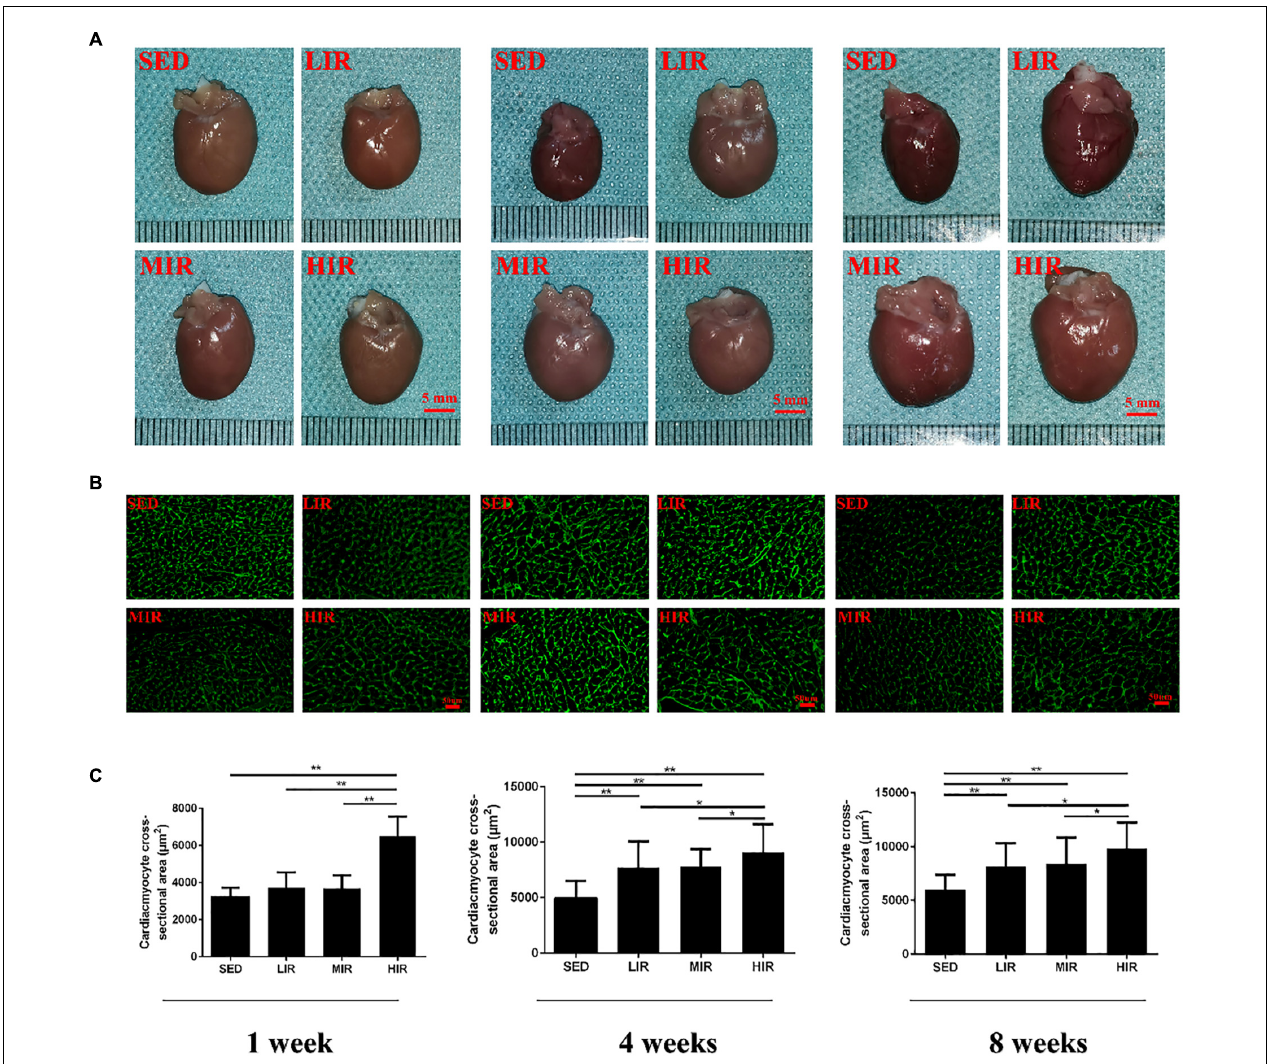
FIGURE 1 | SD rats were subjected to different treadmill running intensities for 1, 4, and 8 weeks. (A–C) Hypertrophic changes of the hearts were observed by gross morphologic examination (A) and WGA staining (B,C) . Scale bar: 5 mm (A) , 50 µ m (B) . Data are presented as the means ± SEM. * P < 0.05, ** P <